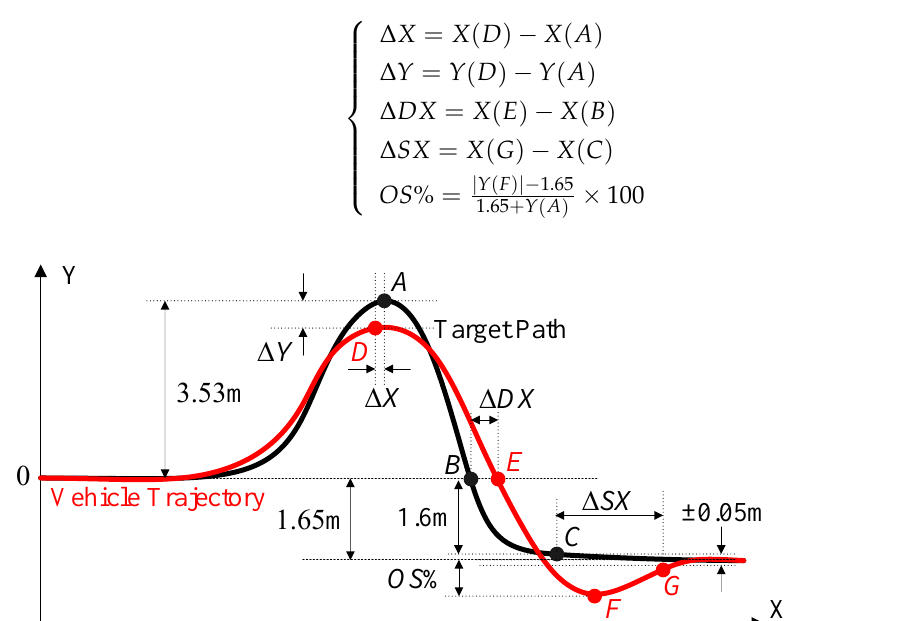
Figure 4. Measures for path tracking performance.